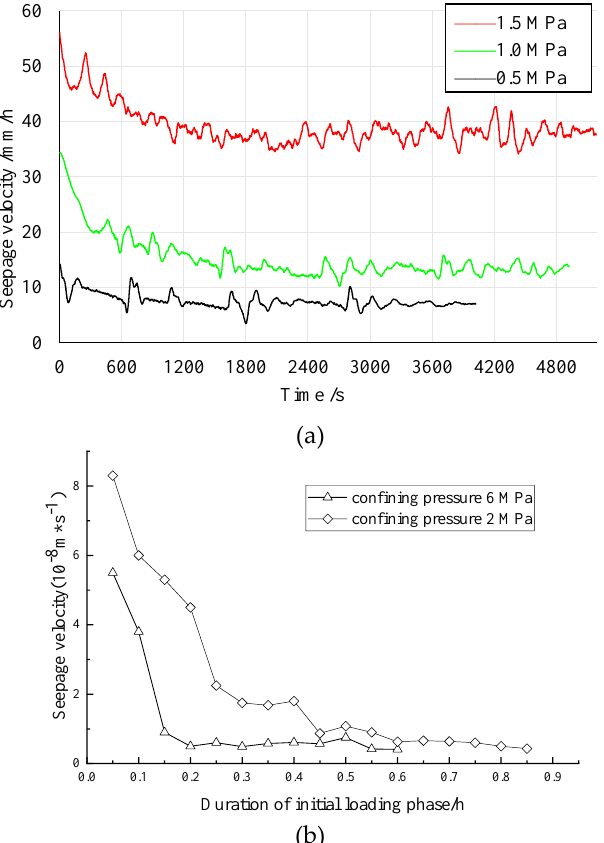
Figure 10. The seepage velocity – time curve in the initial loading stage. ( a ) Red-bed soft rock. ( b ) Hard rock [35].